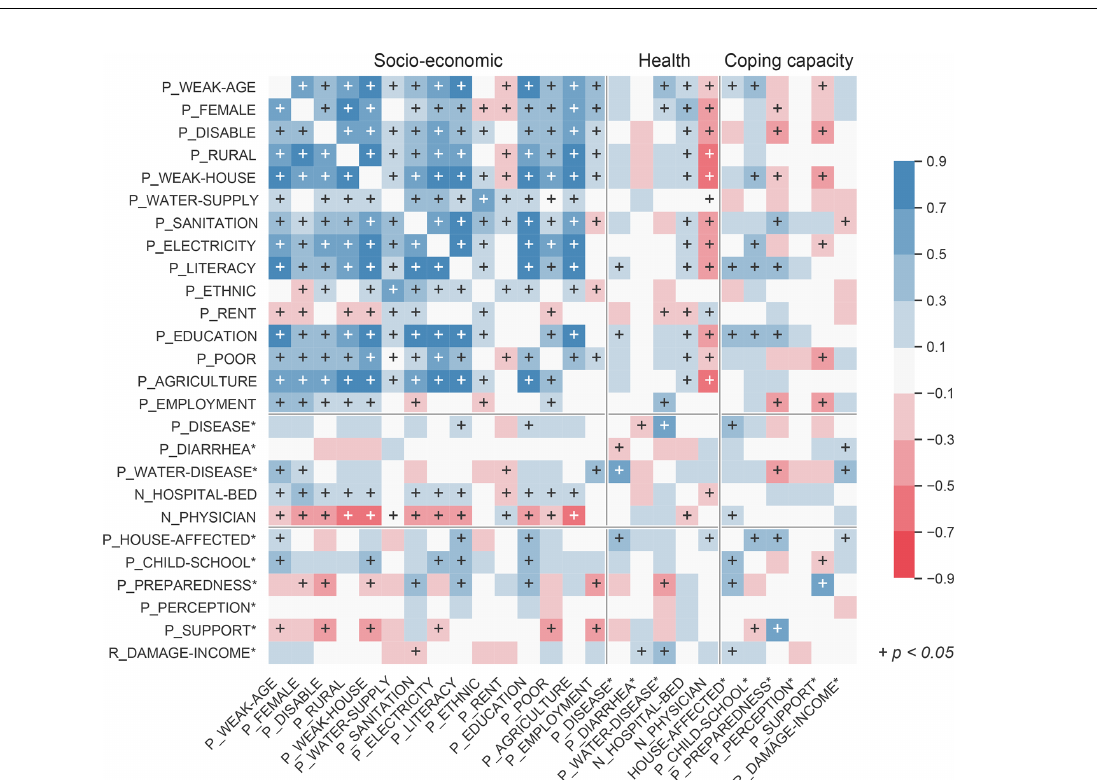
Figure 3. Cross-correlation matrix of the selected indicators calculated at Upazila level unless followed by an asterisk (district level.) The plus sign indicates a statistically significant correlation ( p < 0 .